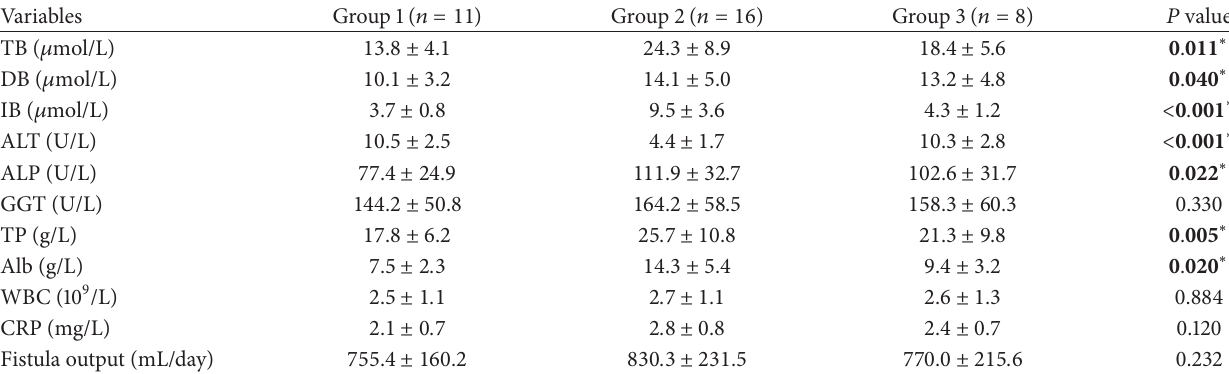
Table 4: Changes from baseline to day 28 for each variable in the fistuloclysis subgroups.